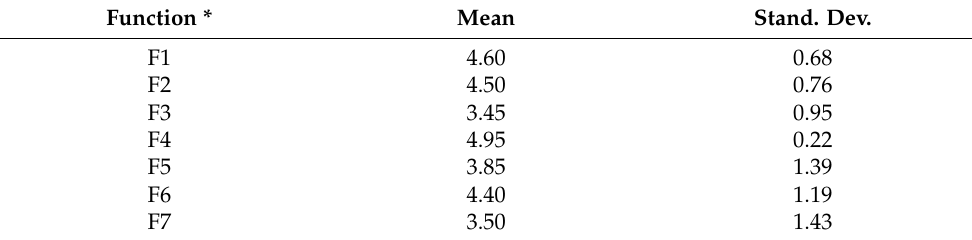
Table 4. Degree of the function